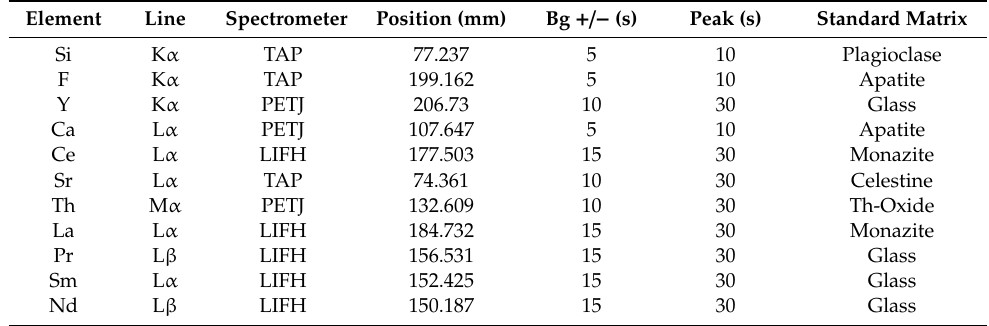
Table A3. Setup for EPMA measurements on REE-carbonate minerals with a beam diameter of 10 µ m.